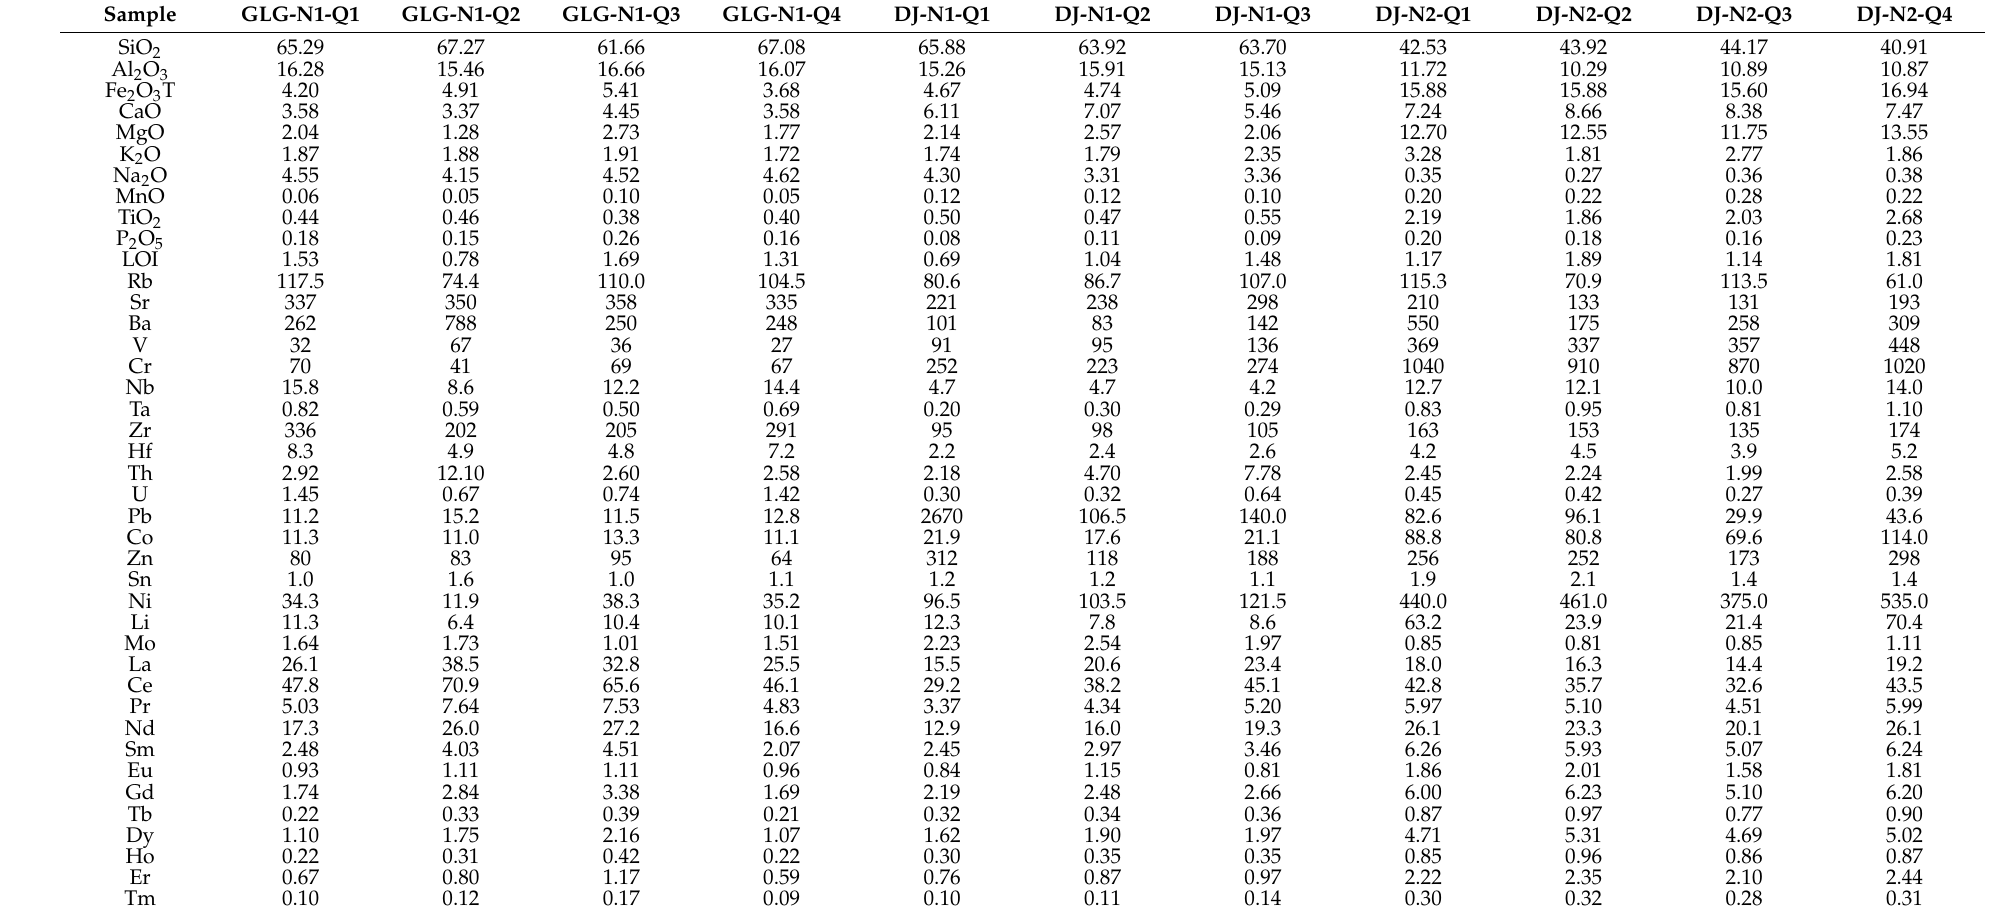
Table 2. Whole-rock major (wt.%) and trace element (ppm) compositions of TTG gneisses and diorites from the deposits in the Liuhe orefield.